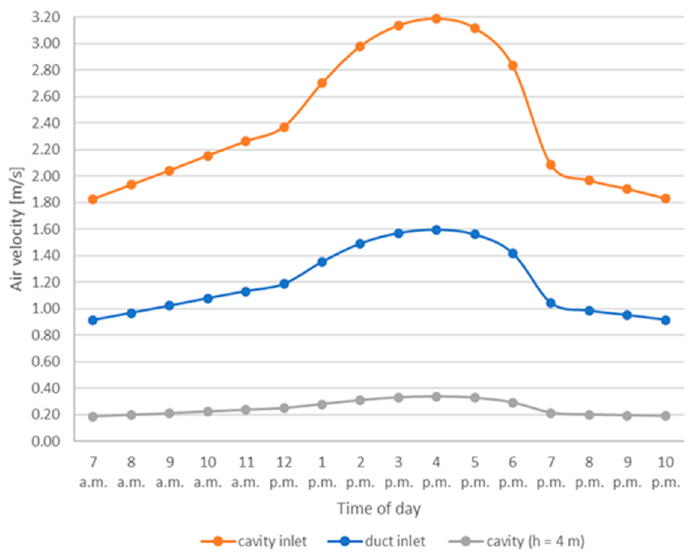
Figure 6. Hourly air velocity values referred to: duct inlet section, cavity inlet section (at the bottom of the façade), cross section of the cavity at a height of 4 m.